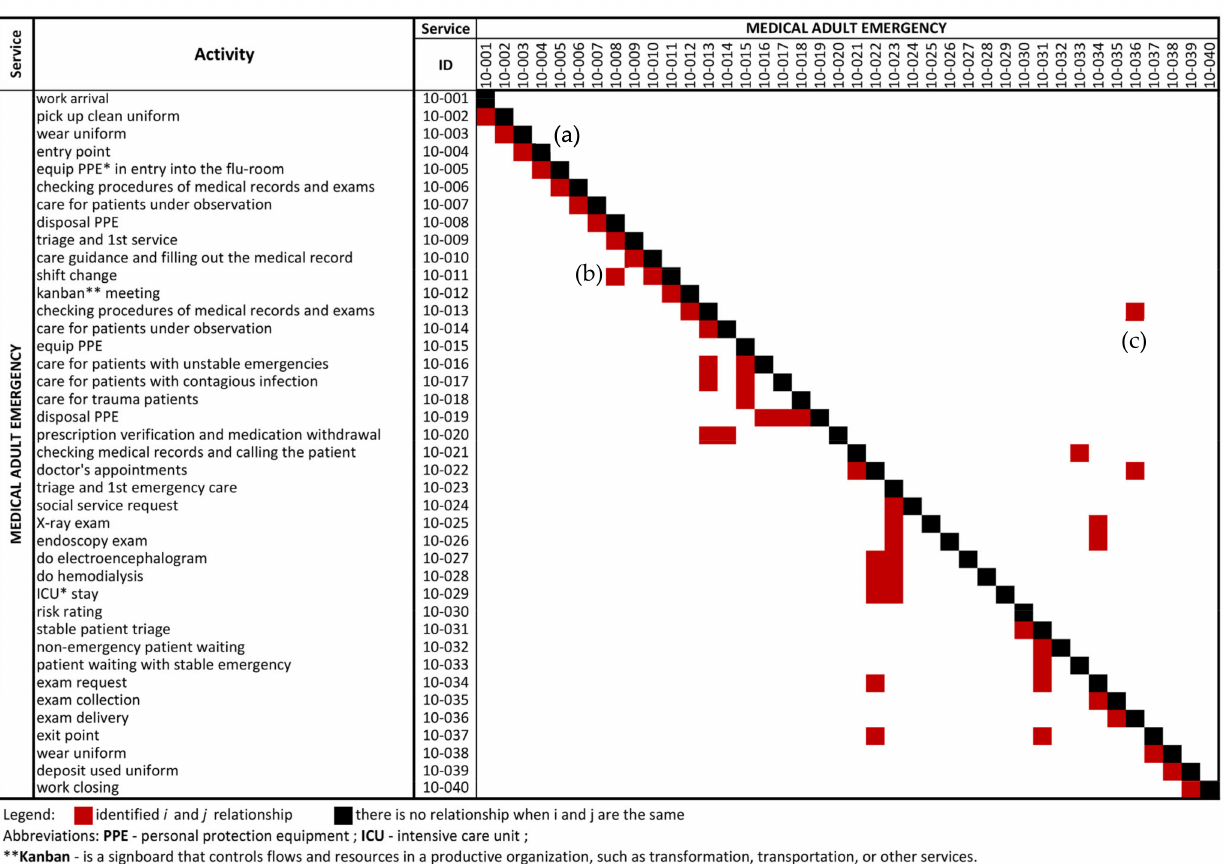
Figure 5. Activities matrix (Ann) in detail, highlighting the medical activities conducted in an adult emergency-care service. This matrix clipping presents 40 activities out of the 325 activities contemplated in the entire matrix (see the full matrix in